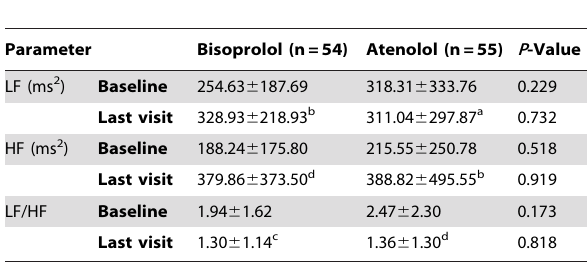
Data are shown as mean 6 SD. HF: high frequency; HRV: heart rate variability; LF: low